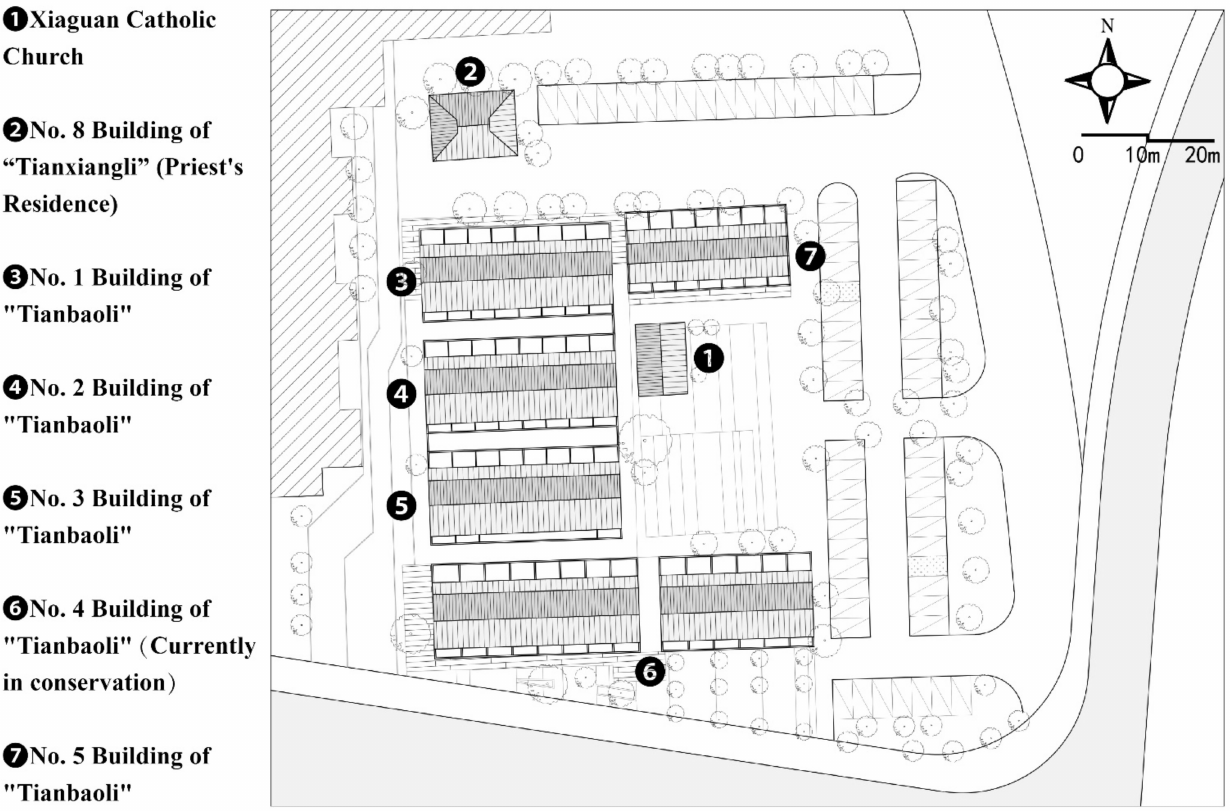
Figure 6. Site plan of the “Tianzihao”